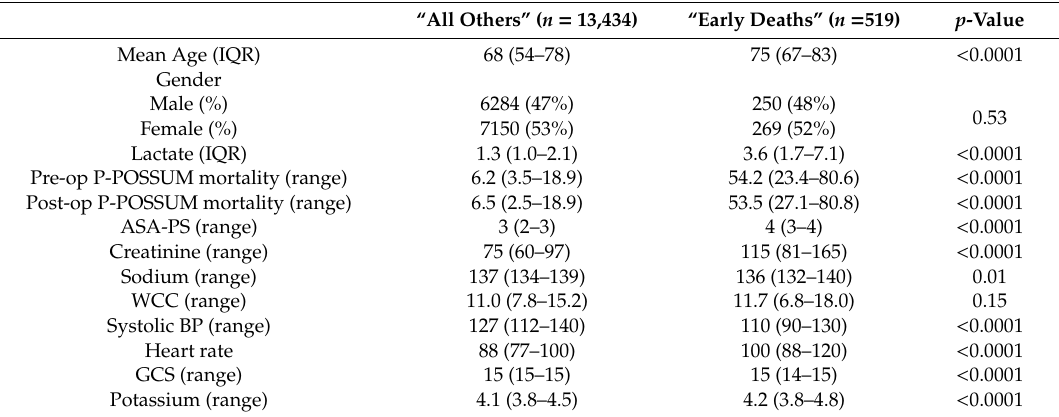
Table 1. Characteristics of patients who either died within 3 days (early deaths) or all